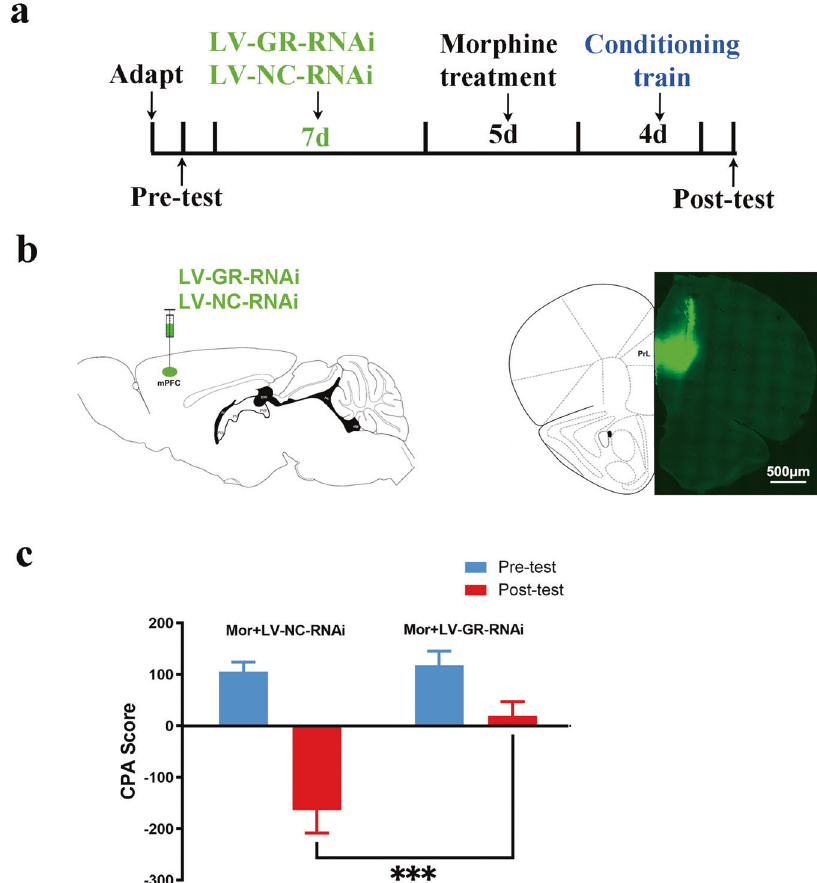
Fig. 5 Effect of GR expression induced by chronic morphine treatment on the retrieval of contextual morphine withdrawal memory. a Experimental timeline for the CPA procedure. b Left: Diagram of virus injection site in mPFC. Right: Image of coronal brain slice showing the expression of LV virus in mPFC. Scale bar, 500 μ m. c Average pre-test and post-test CPA scores in Morphine + LV-NC-RNAi and Morphine + LV- GR-RNAi group (two-way ANOVA, virus treatment factor, F (1,38) = 9.996, P = 0.0031; test condition factor, F (1,38) = 35.56, P < 0.0001; virus treatment x condition, F (1,38) = 7.594, P = 0.0089; Bonferroni post hoc analysis). The post-test CPA scores in Morphine + LV-GR-RNAi was signi fi cantly lower than that of the morphine + LV-NC-RNAi group (two-way ANOVA, Bonferroni post hoc analysis, t = 4.184, *** P = 0.0003). Data are presented as mean ±